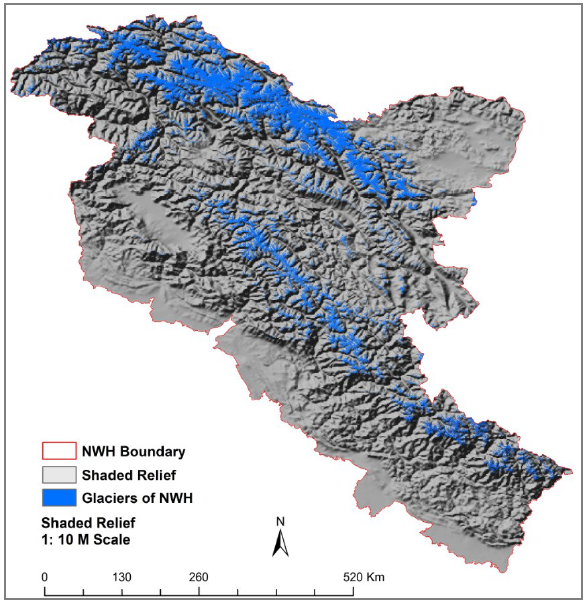
Figure 10. Glaciers of NWH region (Source: RGI-version 6).